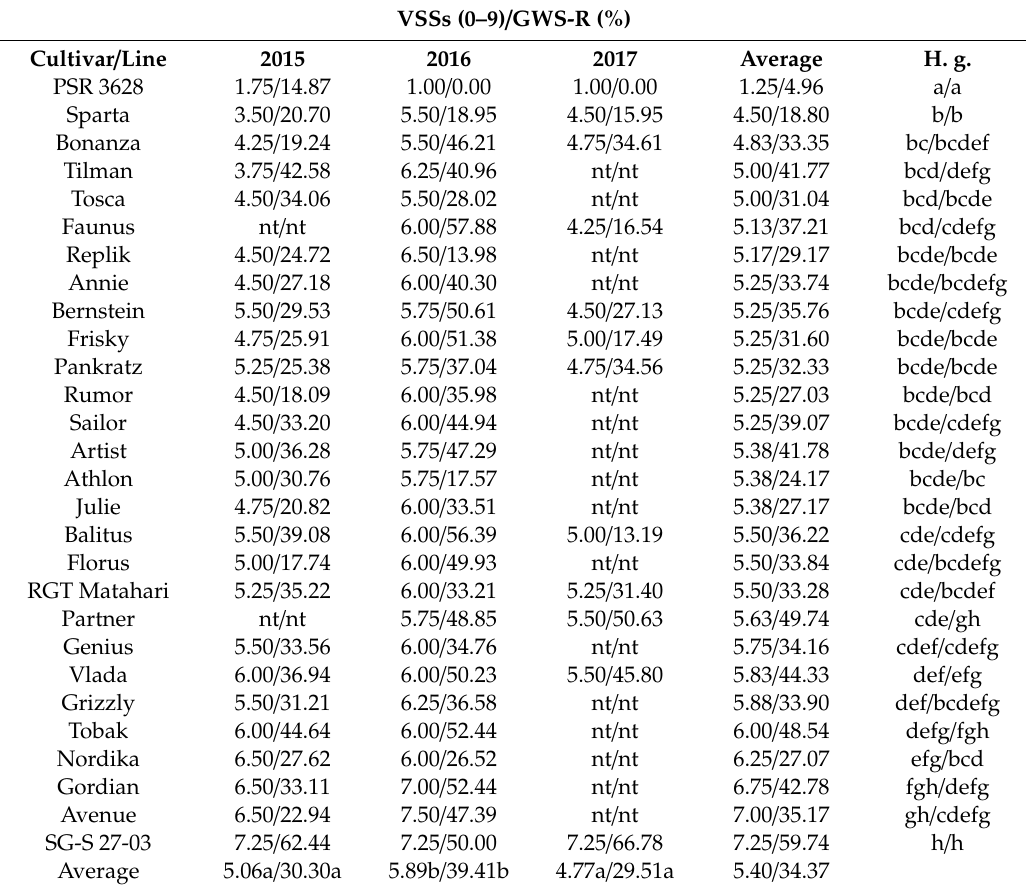
Table 3. Evaluation of the resistance of winter wheat cultivars after BYDV-PAV infection in three-year trials in Prague-Ruzynˇe from 2015 to 2017.